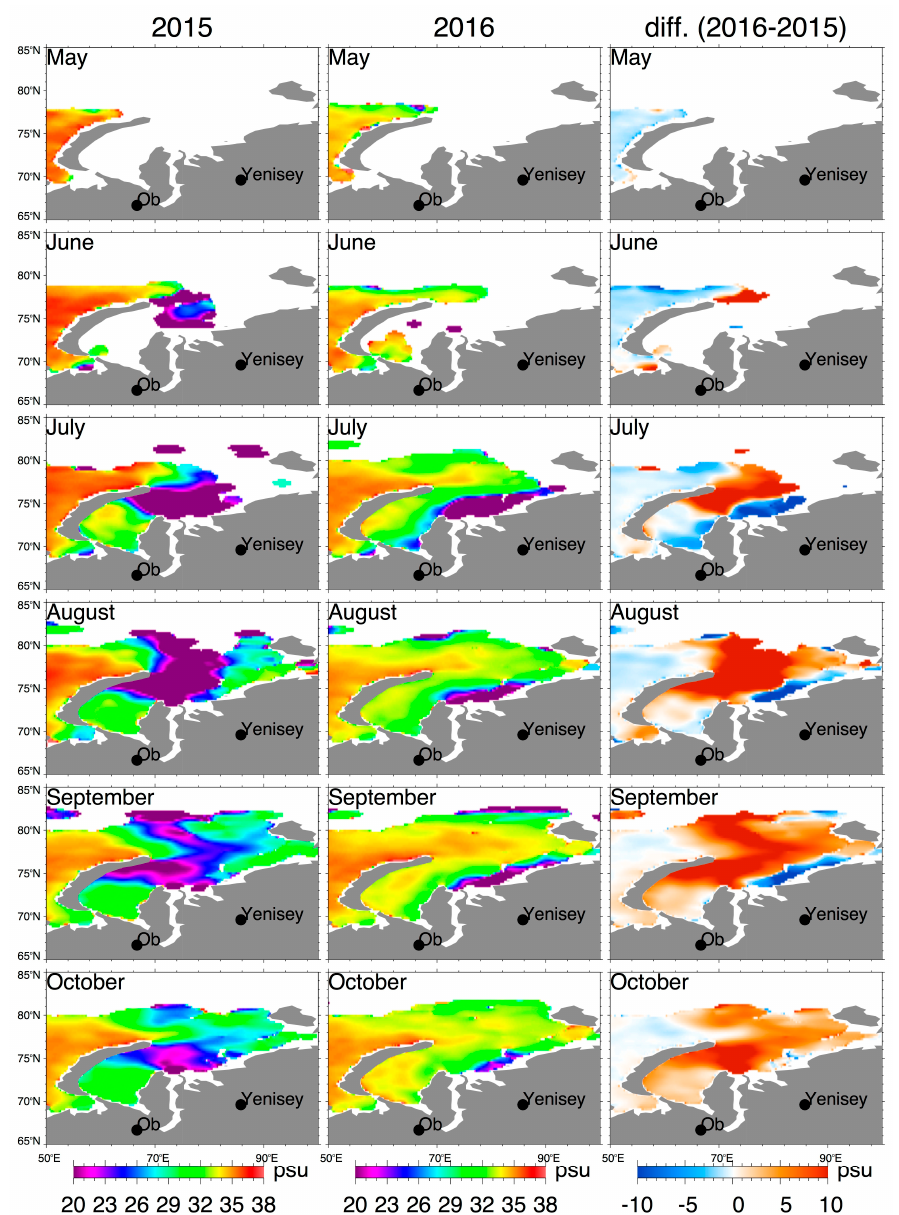
Figure 6. SSS in Kara Sea for the months from May to October (top to bottom) for the year 2015 (left) and 2016 (middle). The corresponding differences (2016 minus 2015) are shown in the right column. Sampling locations of the Ob and Yenisey River are indicated by black dots.